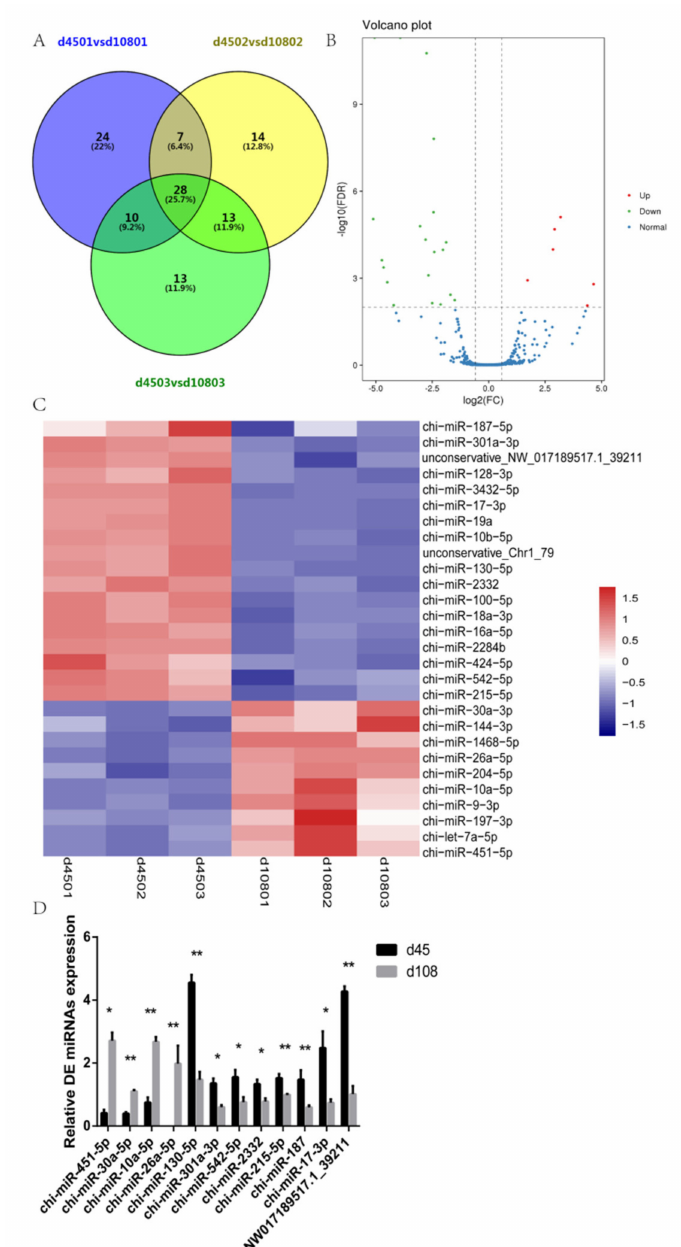
Figure 3. The miRNA-seq results analysis and validation. ( A ) A Venn diagram of di ff erentially expressed miRNAs (DE miRNAs), d4501 vs. d10801 represents the number of di ff erential miRNAs of the first sheep in two di ff erent periods, d4502 vs. d10802 and d4503 vs. d10803 have the same meaning. The overlapping circles represent the number of di ff erential miRNAs between the combinations. ( B ) A volcano map of di ff erentially expressed miRNAs. The volcano plot shows the levels of expression of the DE miRNAs shared between the 45- and 108-day-old samples. ( C ) A heat map of miRNAs. The abscissa represents the sample name and the clustering result for the sample, and the ordinate represents the clustering result for the di ff erentially expressed miRNAs. Red indicates upregulation, and blue indicates downregulation. ( D ) RT-qPCR analysis of twelve DE miRNAs, with the relative expression calculated by the 2 − ∆∆ Ct method; * p < 0.05 and ** p <